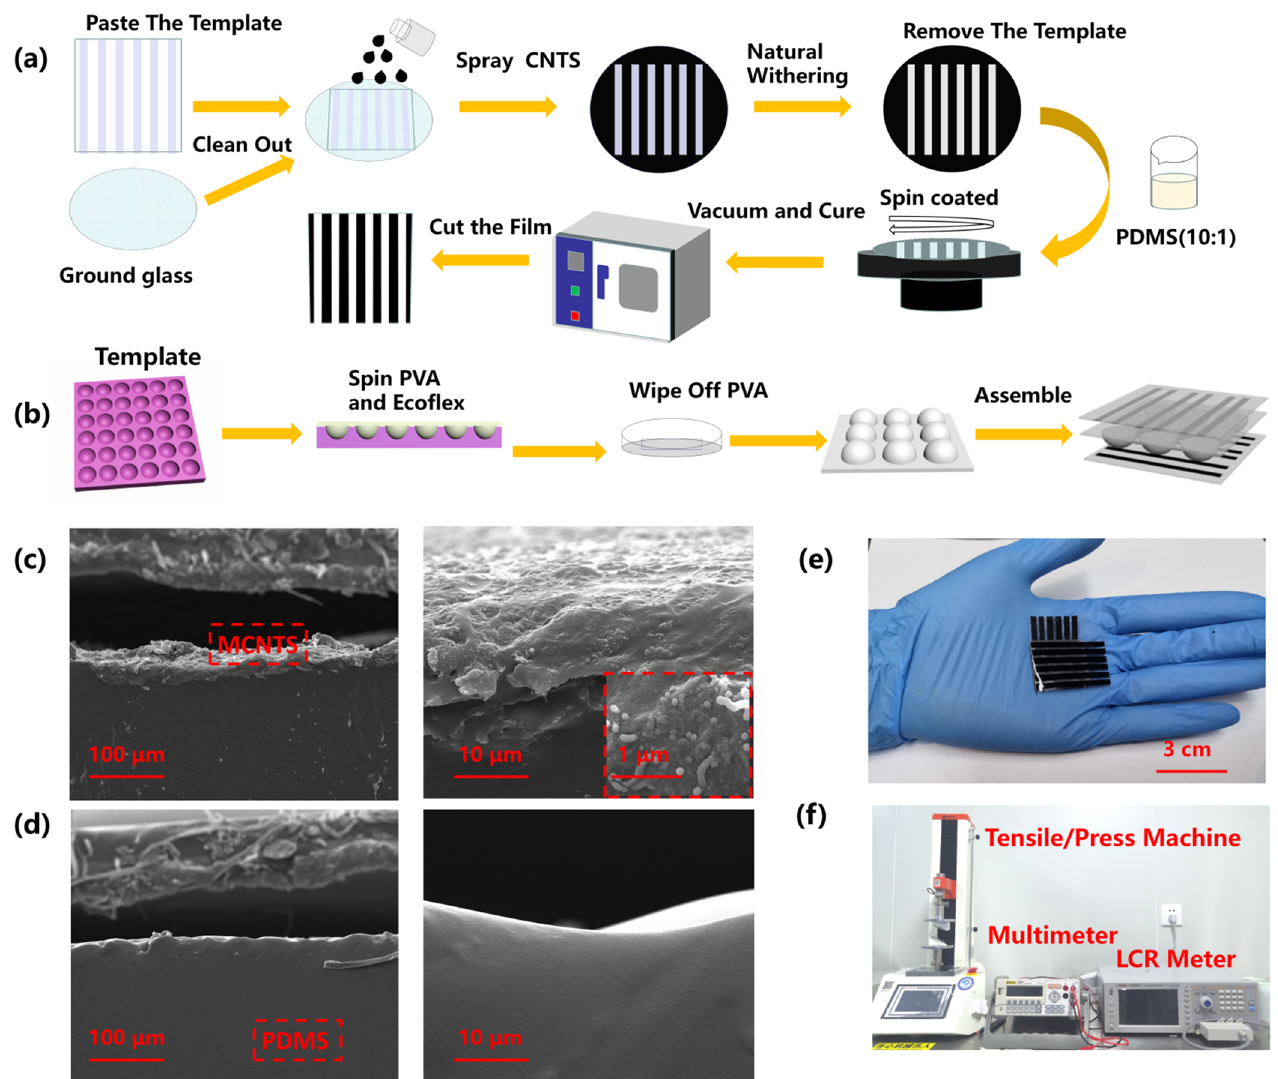
Figure 2. Fabrication process and experiment platform of the ODT sensor. ( a ) The fabrication process of the micro-spined stripe electrodes of the pressure sensor. ( b ) The fabrication process of the hemispherical hilly dielectric layer. ( c ) SEM images from the section view of nanocomposite materials under different magnification, focusing on the MWCNT conducting layer. ( d ) SEM images from the section view under different magnifications, focusing on the bare PDMS microstructure. ( e ) Optical photograph of the soft ODT sensor. ( f ) Optical photograph of the testing system during the experiment.